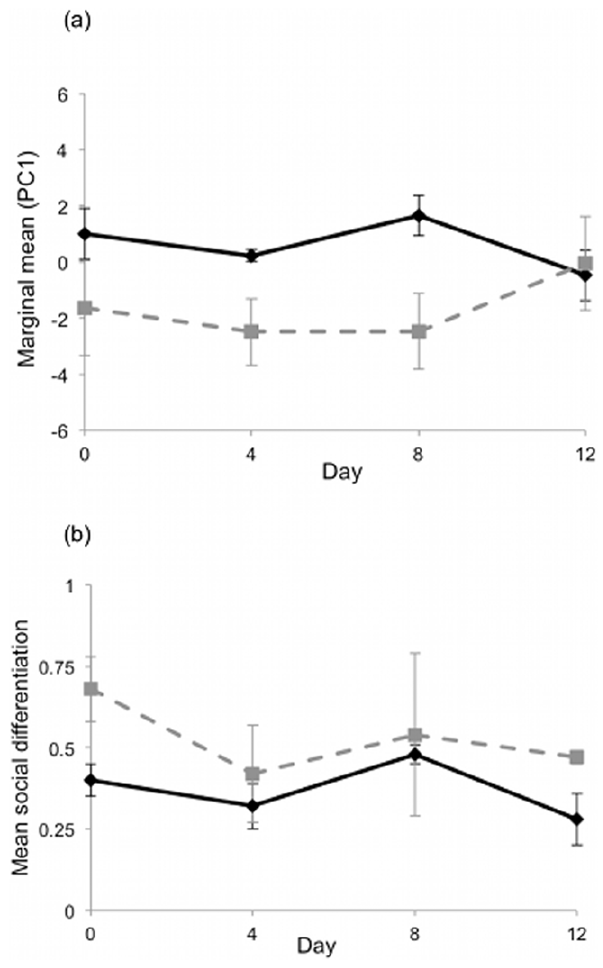
Figure 1. Effect of time (day) and predation risk on guppy social network measures. Figure a represents the marginal means ( 6 SE) for PC1 while figure b shows the mean population social differentiation. Solid lines represent high predation populations; dashed lines are low risk sites.